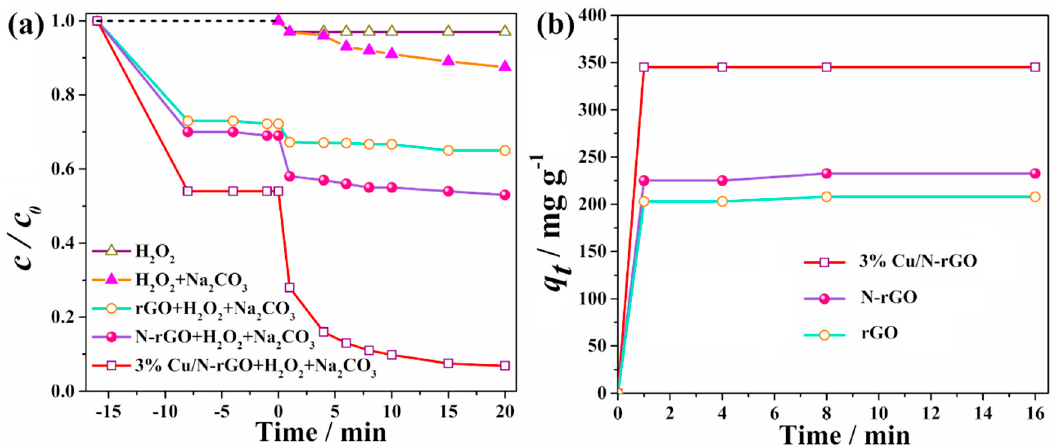
Figure 4. ( a ) Adsorption and degradation of RhB in different systems: H 2 O 2 , H 2 O 2 + Na 2 CO 3 , rGO + H 2 O 2 + Na 2 CO 3 , N-rGO + H 2 O 2 + Na 2 CO 3 , and 3%Cu/N-rGO + H 2 O 2 + Na 2 CO 3 . ( b ) Adsorption kinetics of RhB on rGO, N-rGO, and 3%Cu /